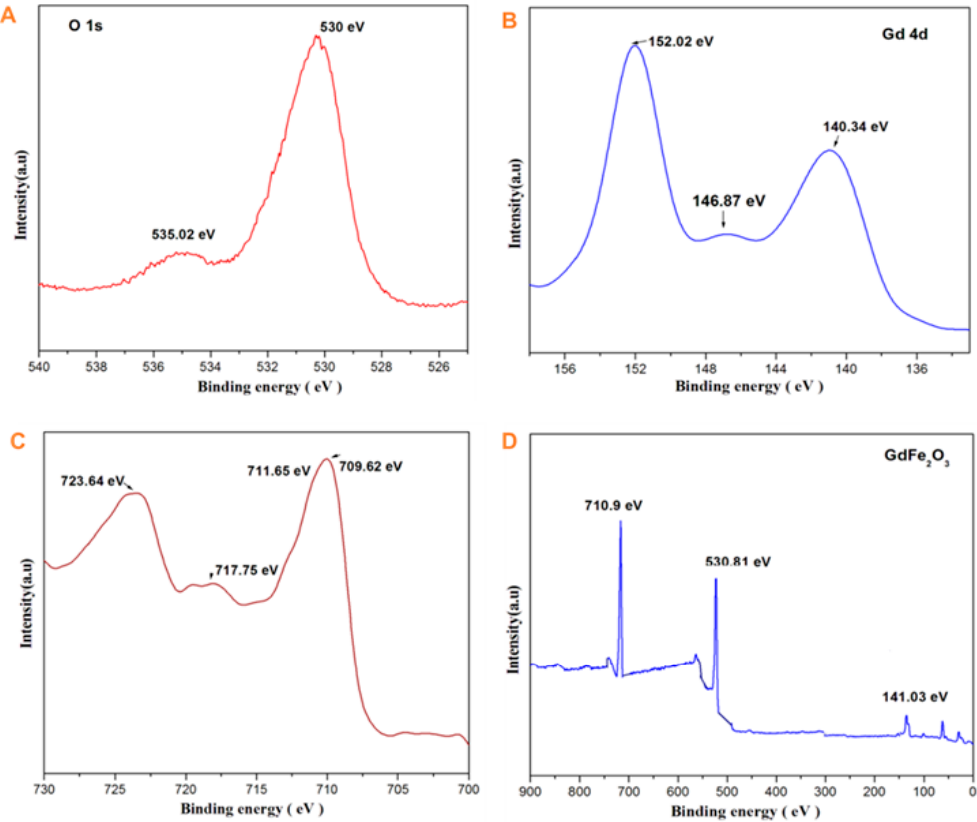
Figure 6. ( A – D ) XPS spectra of GdFeO 3 nanoparticles annealed at a temperature of 800 ◦